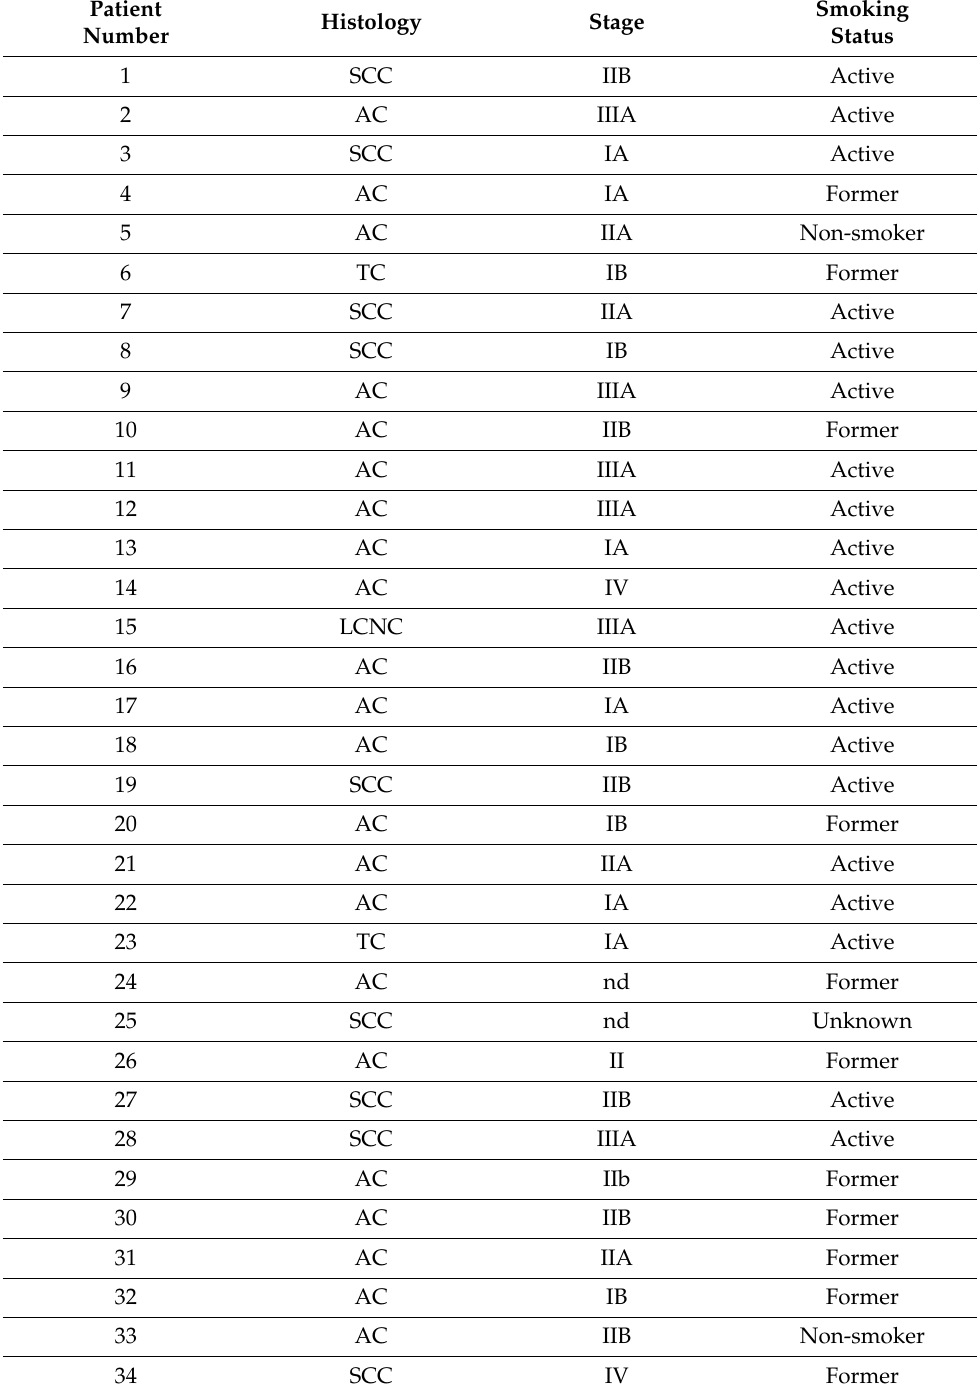
Table 3. Clinical characteristics of the patients included in the